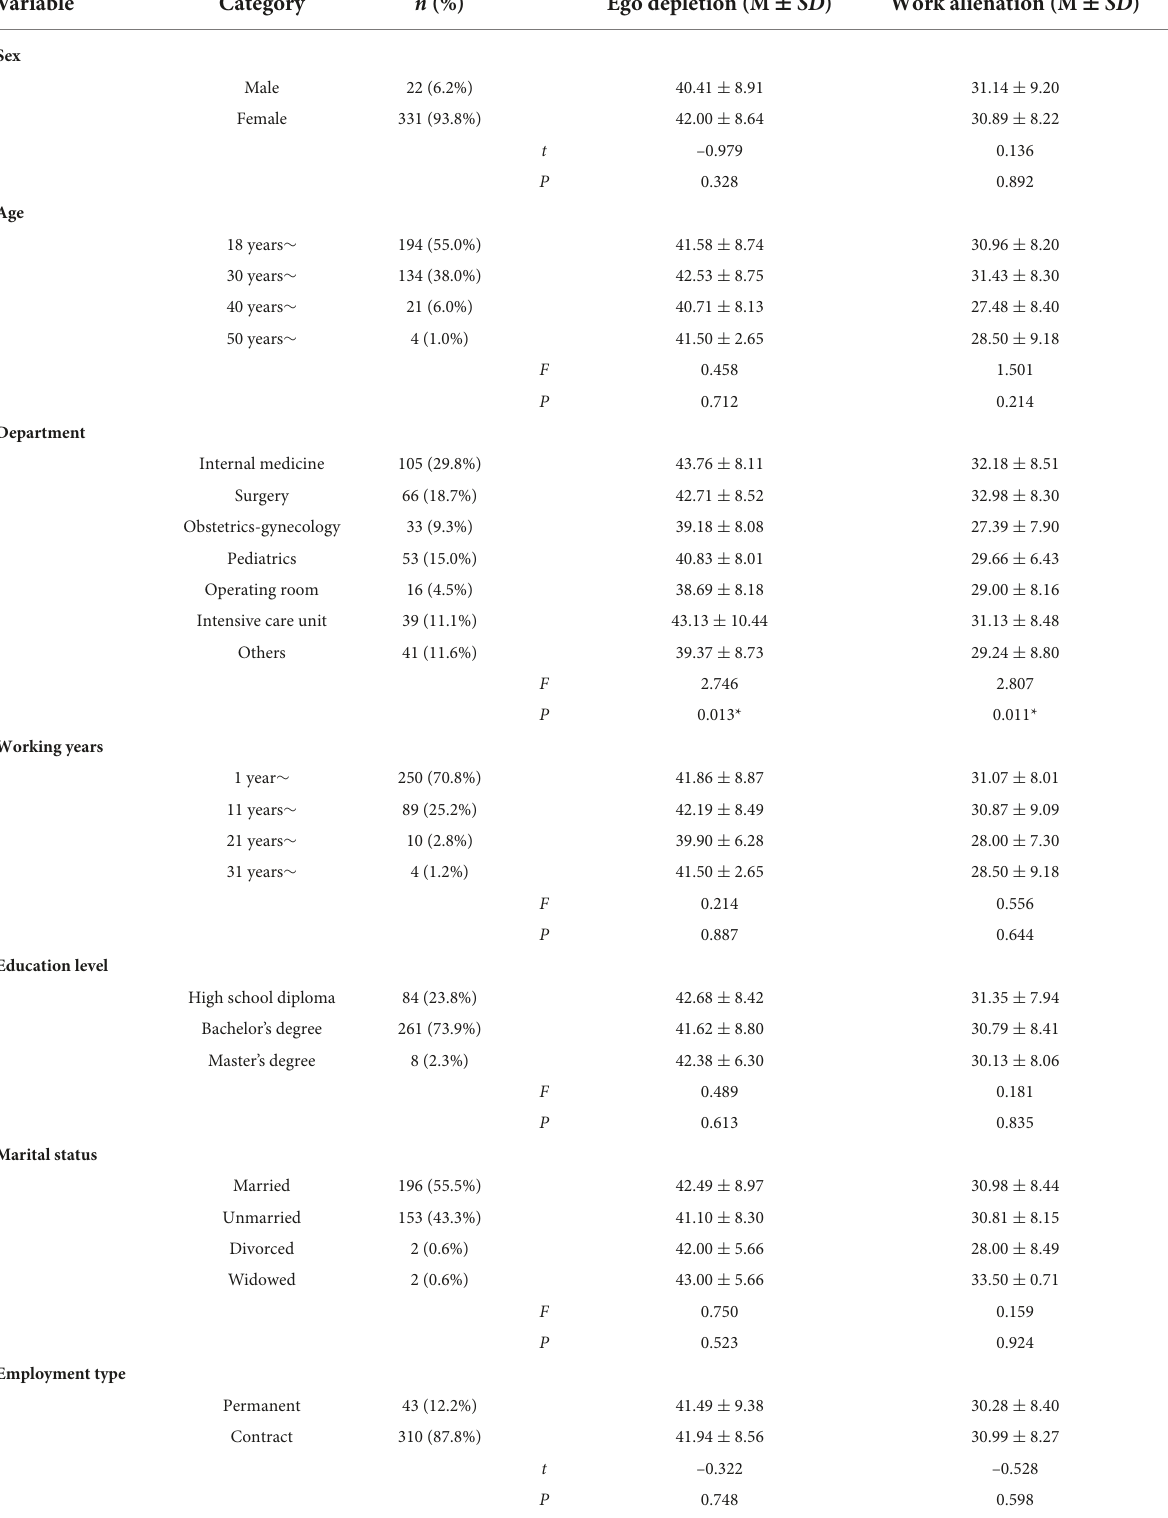
TABLE 1 Sociodemographic characteristics of the participants and the comparison of ego depletion and work alienation ( N = 353).